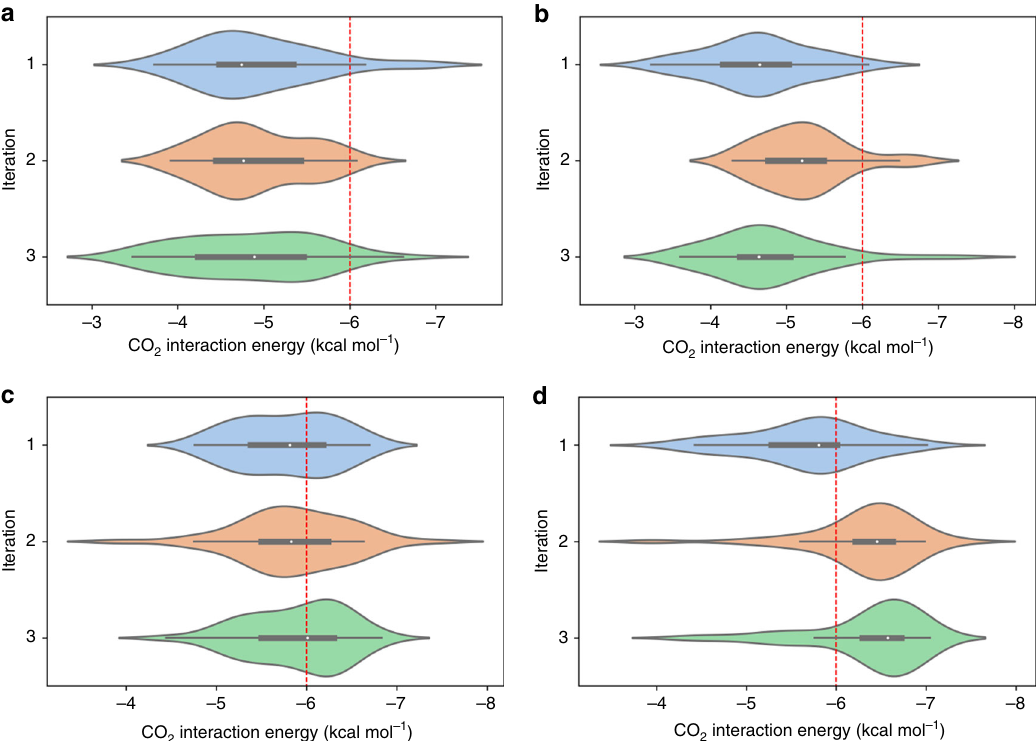
Fig. 5 CO 2 interaction energy distribution shown as horizontal violin plots for the fi rst, second, and third active-learning steps. ( a ) CM, ( b ) BoB, ( c ) SOAP, and ( d ) PI. The height of the shape shows the frequency of occurrences, the white dot along the axis iteration depicts the median, and the bold line the middle 50% of the data. The thinner line corresponds to the range of all the data. The dashed line at − 6.00kcalmol − 1 marks cases with stronger CO 2